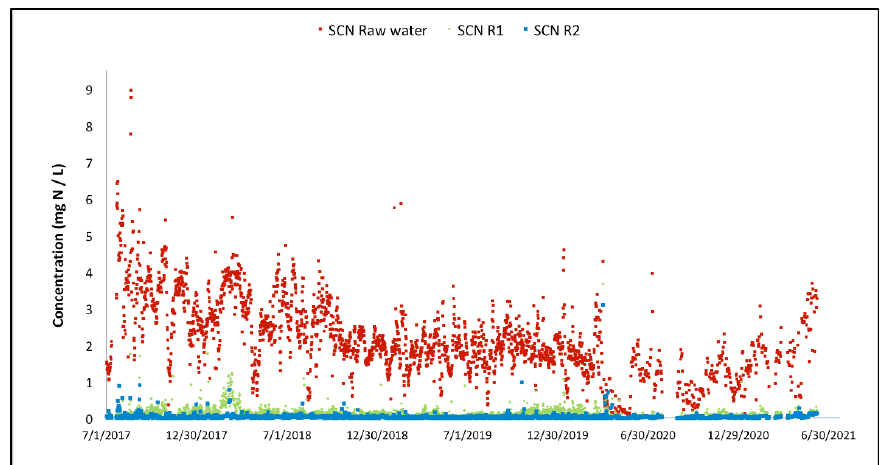
Figure 8. Variation of the cyanate concentration across the two-stage MBBR reactors.